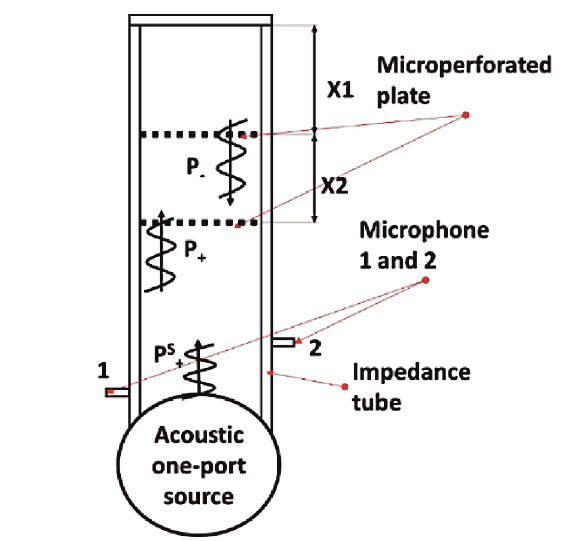
Fig. 3. One-port measurement set-up for the experimental determination of materials ʼ absorption coefficient [15].